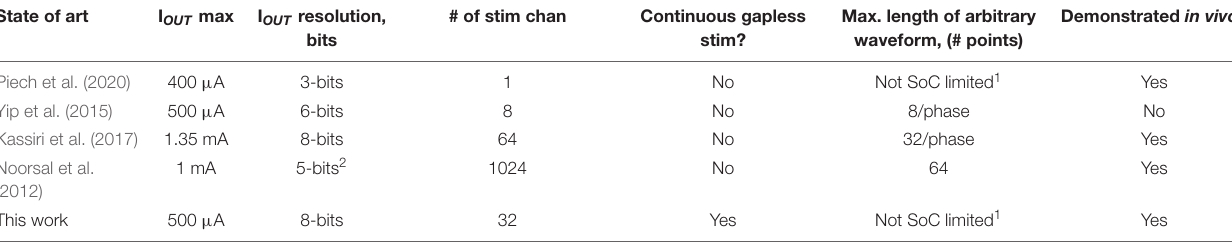
TABLE 2 | Comparison of state-of-the-art SoC-based arbitrary waveform neural stimulators. State of